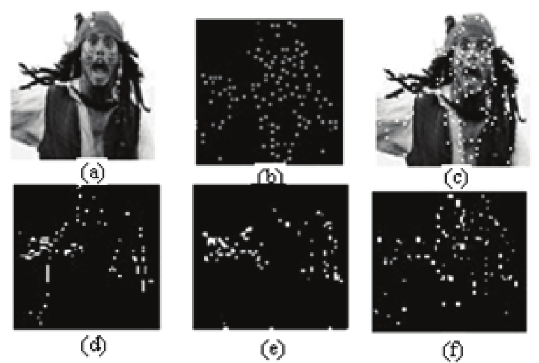
Figure 8: (a) Original Image (b)Proposed method (c) Superimposed image (d) Loupias method[17] (e)Song’s method[22] (f) Tsai’s method [27]